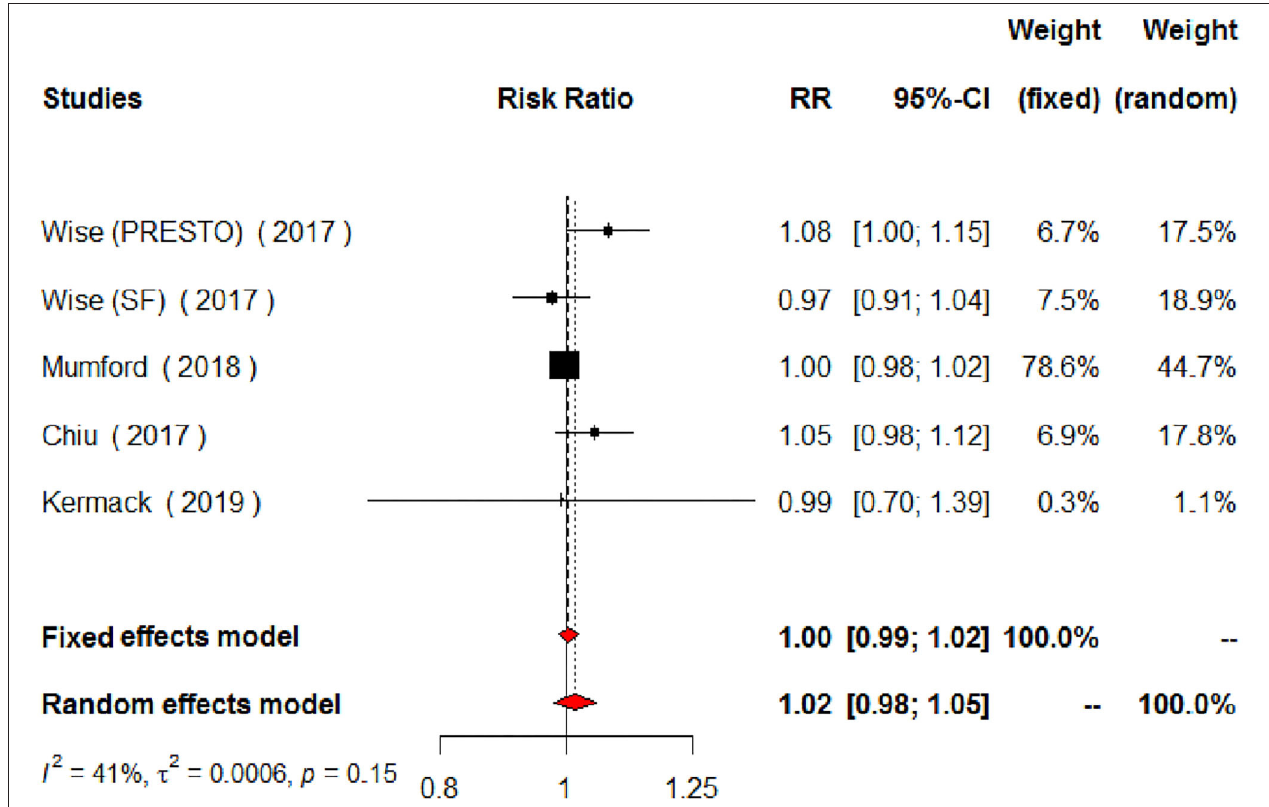
FIGURE 4 | Forest plot for the meta-analysis of the relationship between periconceptional intake of ω -3 PUFAs and pregnancy achievement ( n = 2,095).